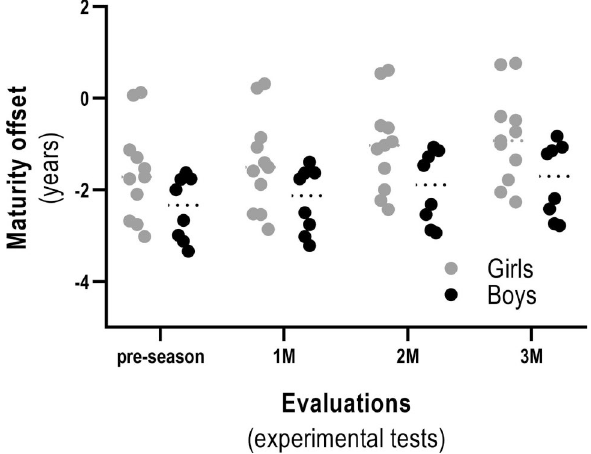
Figure 2 - T200 performance (s) for girls and boys at each evaluation; * p < 0.05; n = 11 girls and 8 boys.